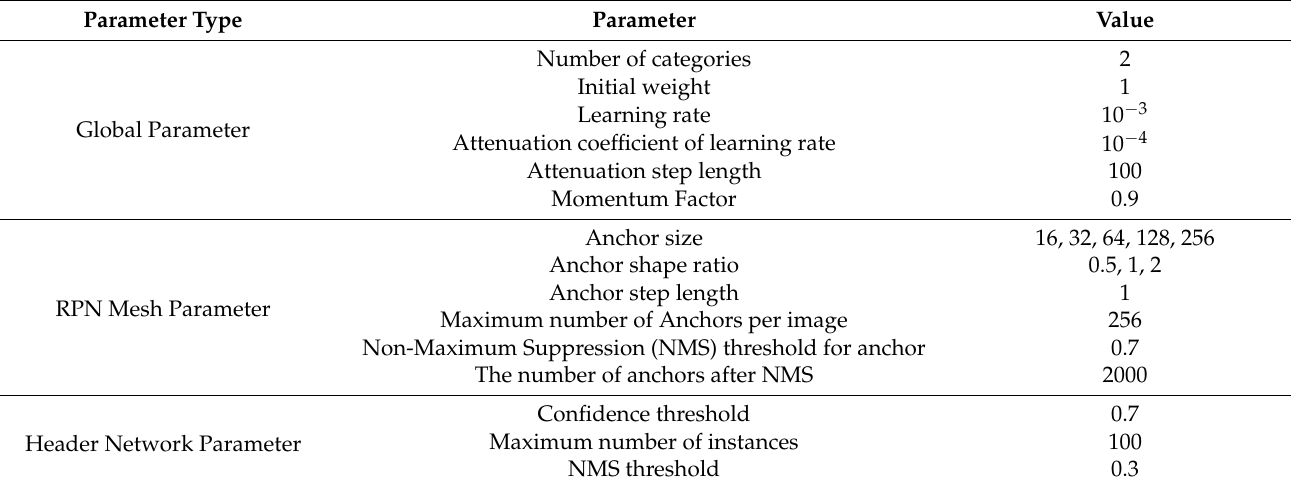
Table 1. Key training